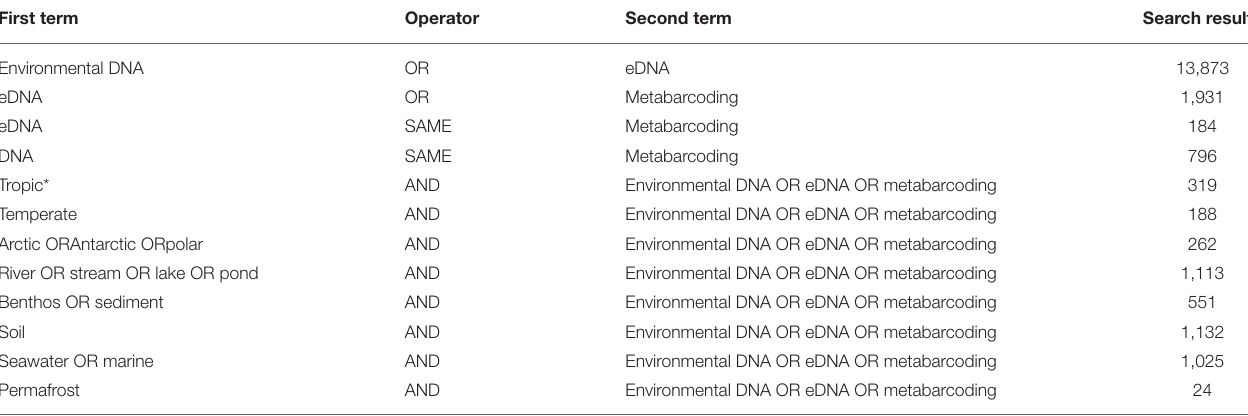
TABLE 1 | Results of Web of Knowledge searches returned for different environmental DNA/eDNA/metabarcoding, search terms (found anywhere in the article), associated with different sample types (water, river/stream/lake/pond, benthos/sediment, soil, seawater/marine, and permafrost), or geographic region (tropic * , temperate, Arctic/Antarctic/polar).